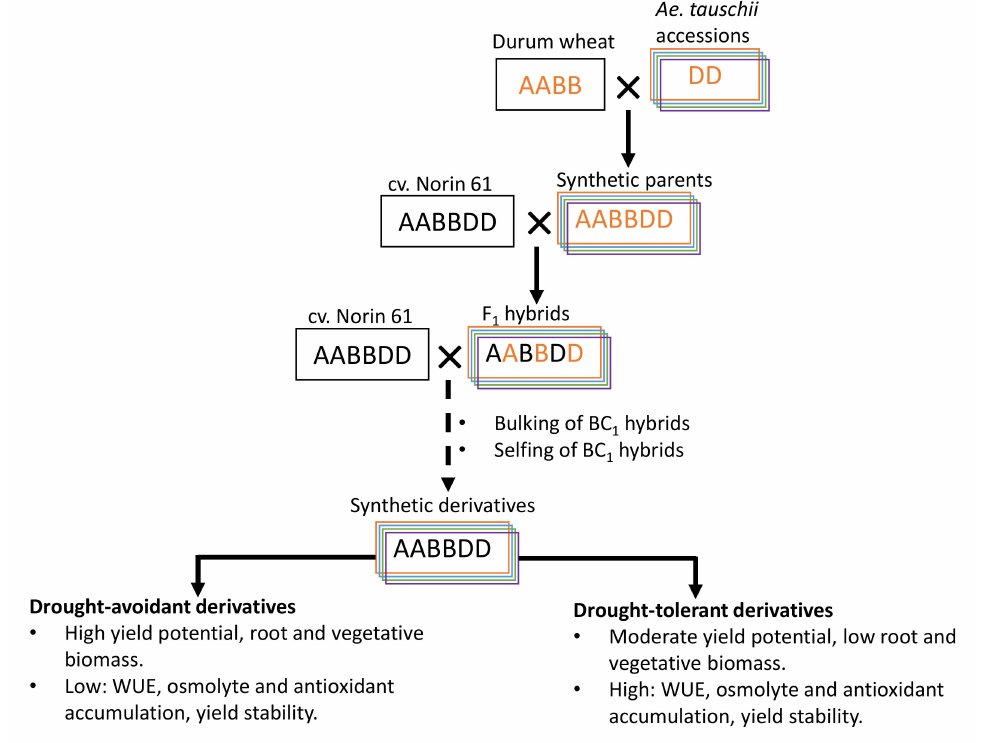
Figure 4. Schematic diagram of a diversity breeding scheme showing wide hybridization, selection, and characterization for drought resistance in wheat (adapted from Tsujimoto et al. [18]). BC, backcross; WUE, water use e ffi